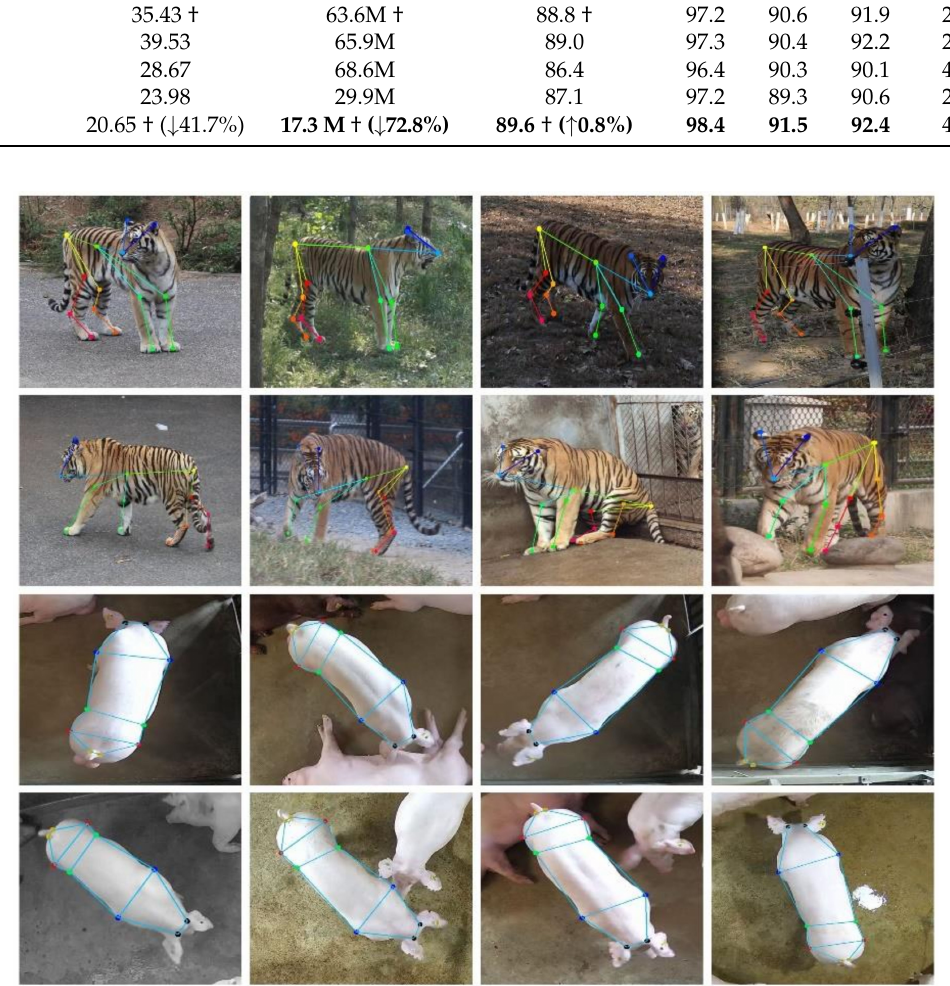
Figure 7. Detection results of HRST on pig and ATRW test